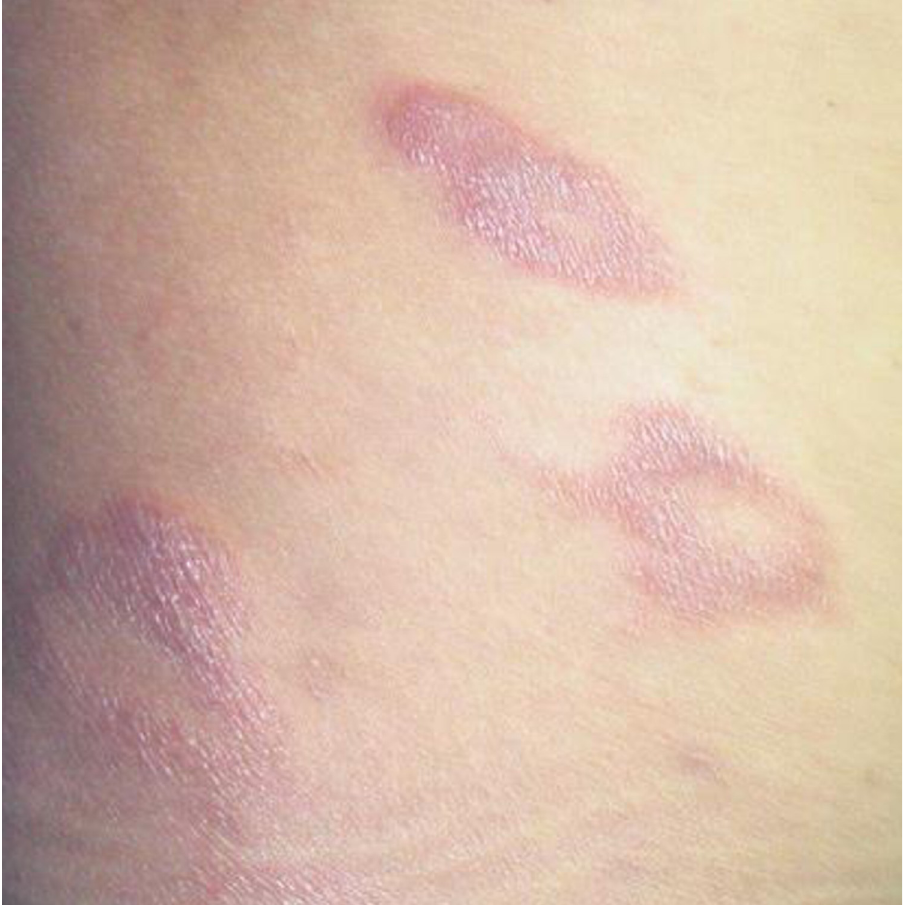
Fig 4. IRIS type 4 after introduction of HAART in patient 5: BT leprosy in T1R on the right flank.